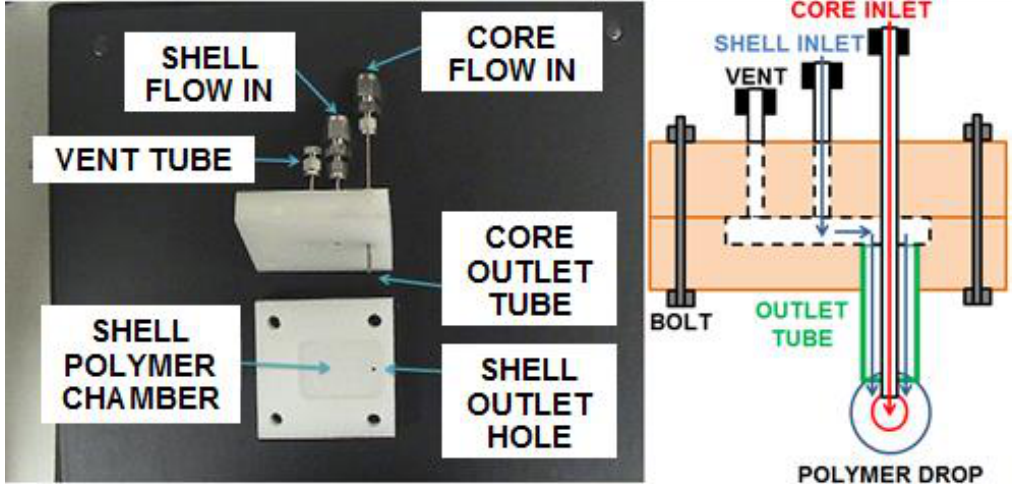
Figure 2. Photograph and schematic of the core–shell electrospinning